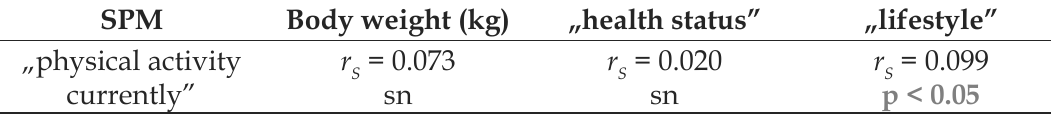
Rank correlation coef (cid:192) cient (Spearman) rS for individual meters.